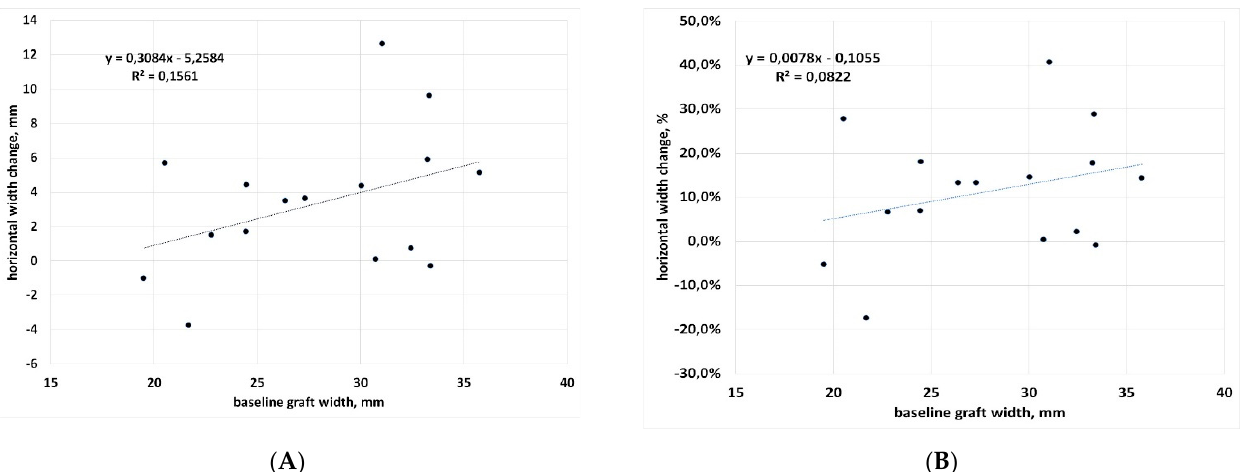
Figure 4. Regression analysis for mesio-distal dimension change with respect to baseline. ( A ) data in mm; ( B ) data in percentage.